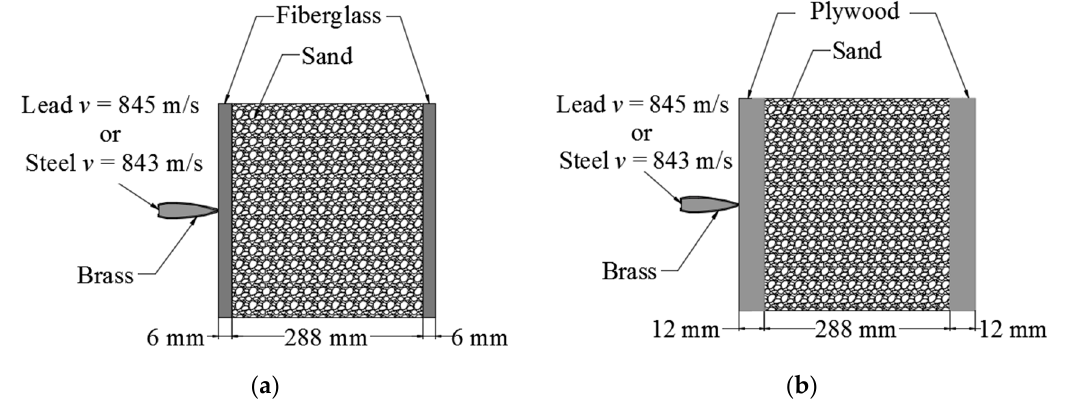
Figure 3. Components of the ballistic blocks in ( a ) the FSF system and ( b ) the PSP system.